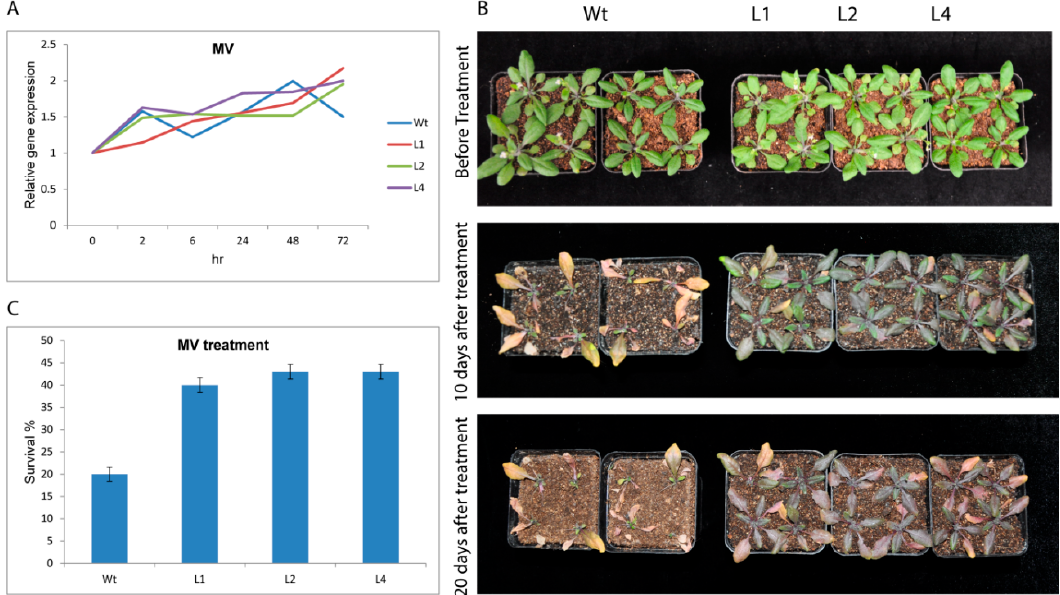
Figure 4. Oxidative stress analysis of transgenic lines and Wt plants ( A ) Expression level of GhTRX134 in transgenic Arabidopsis and Wt was monitored by qRT-PCR. ( B ) Phenotypes of GhTRX134 -overexpressing and Wt plants after treatment with 20 µM methyl viologen (MV) for 20 days. ( C ) The survival percentage of transgenic and Wt plants after oxidative stress. Values are the mean of three replicates ± SDs. Student’s t -test was used to determine the significant differences compared to Wt.